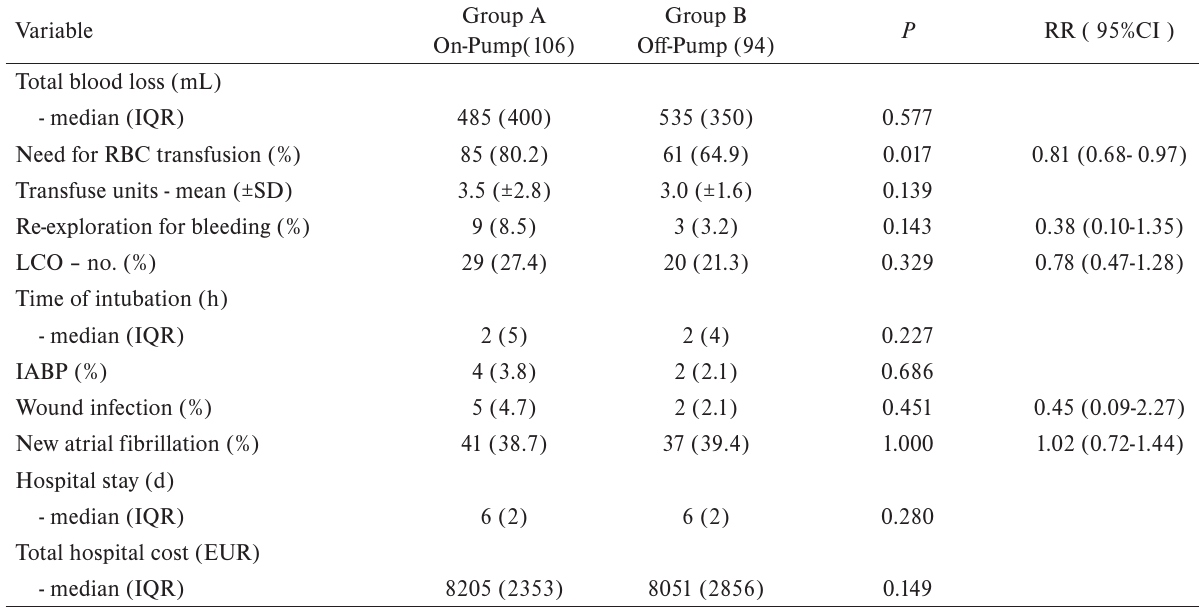
Table 3. Postoperative data (intention-to-treat) *